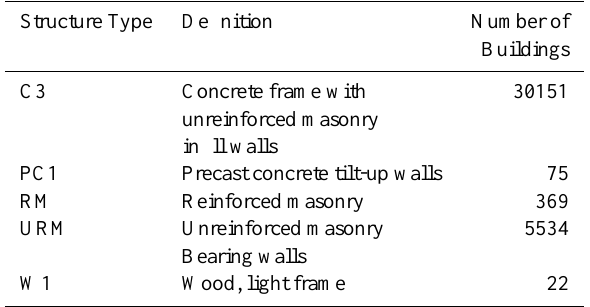
Table 3. Number and structure types of buildings.